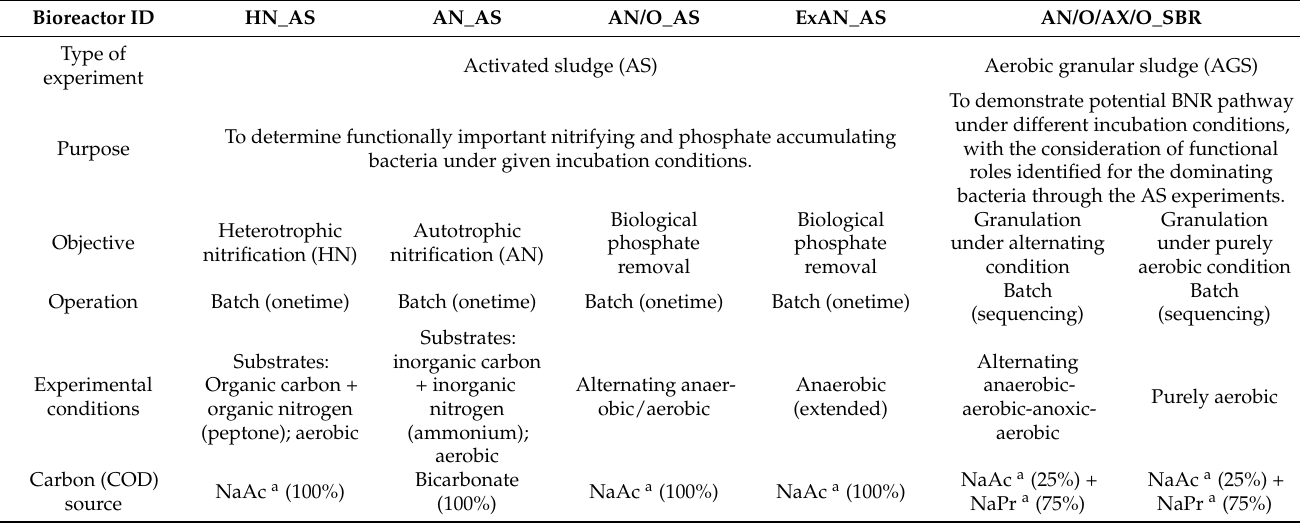
Table 2. Experiment design and operating